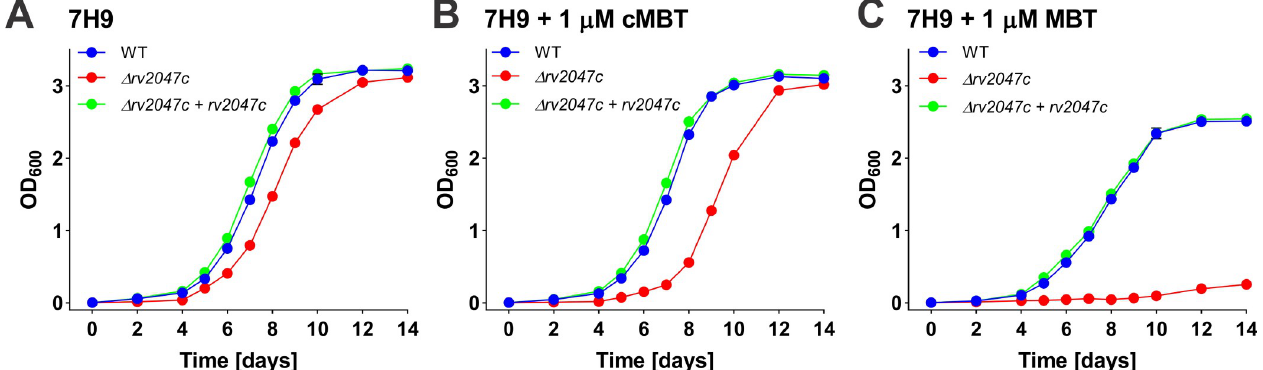
Fig 6. Growth of the M . tuberculosis Δ rv2047c mutant. Growth of Mtb mc 2 6230 (as WT), Δ rv2047c (ML2256) and the complementation Δ rv2047c mutant (ML2257) in 7H9 Middlebrook medium (A) supplemented with 1 μ M carboxymycobactin (B) and 1 μ M mycobactin (C), respectively. The initial OD 600 of all the cultures is 0.01. Error bars represent standard deviations from the mean results of biological triplicates.